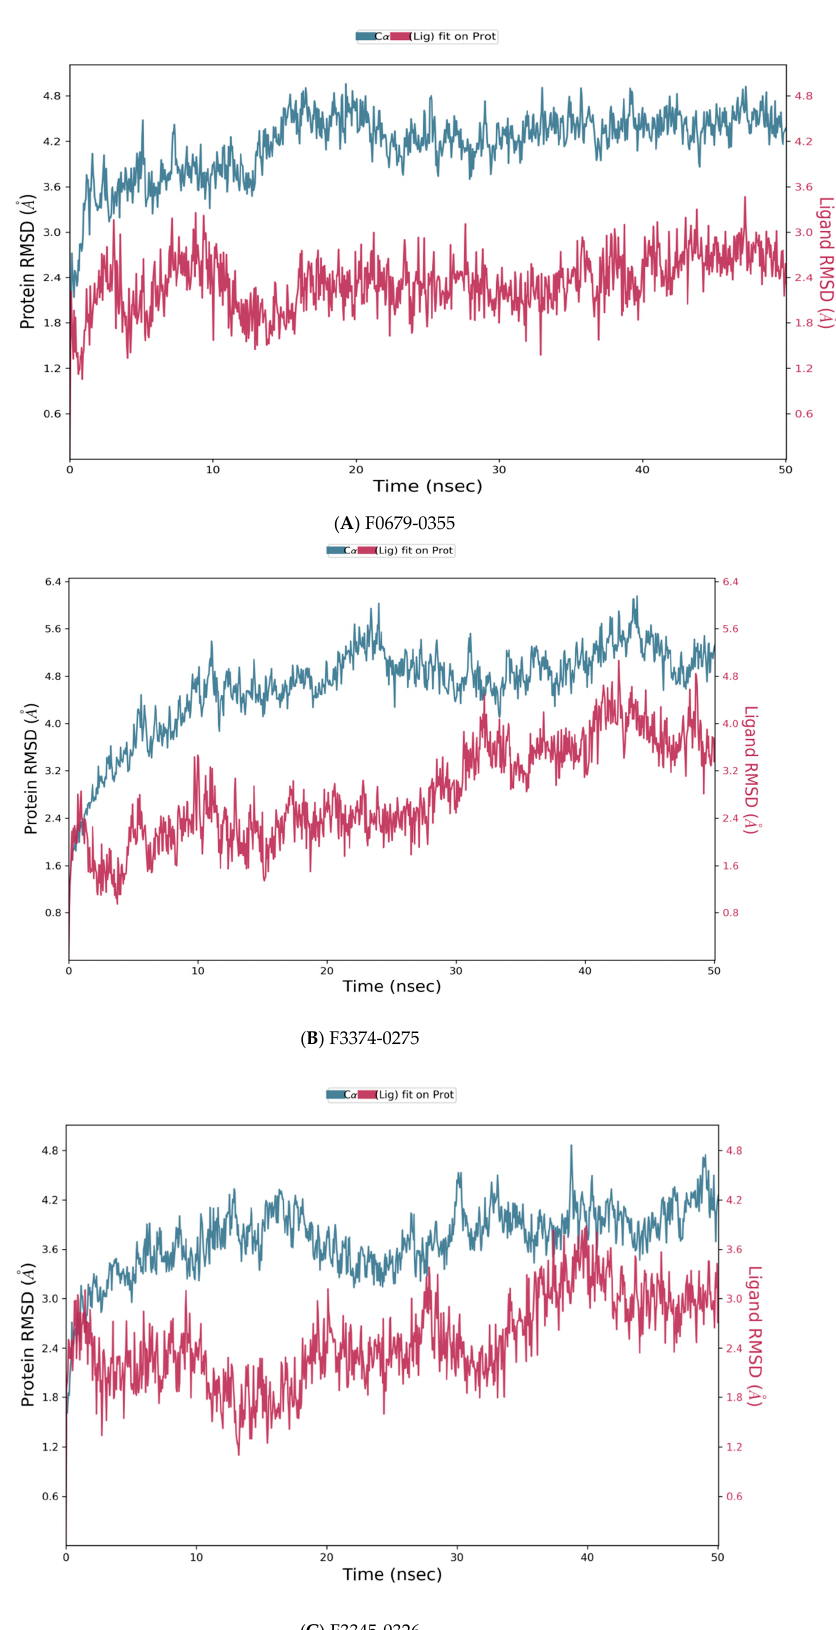
(RMSD) Figure 5, root mean square fluctuation (RMSF) Figure 6 and protein–ligand con- tacts were calculated from the MD trajectory analysis.